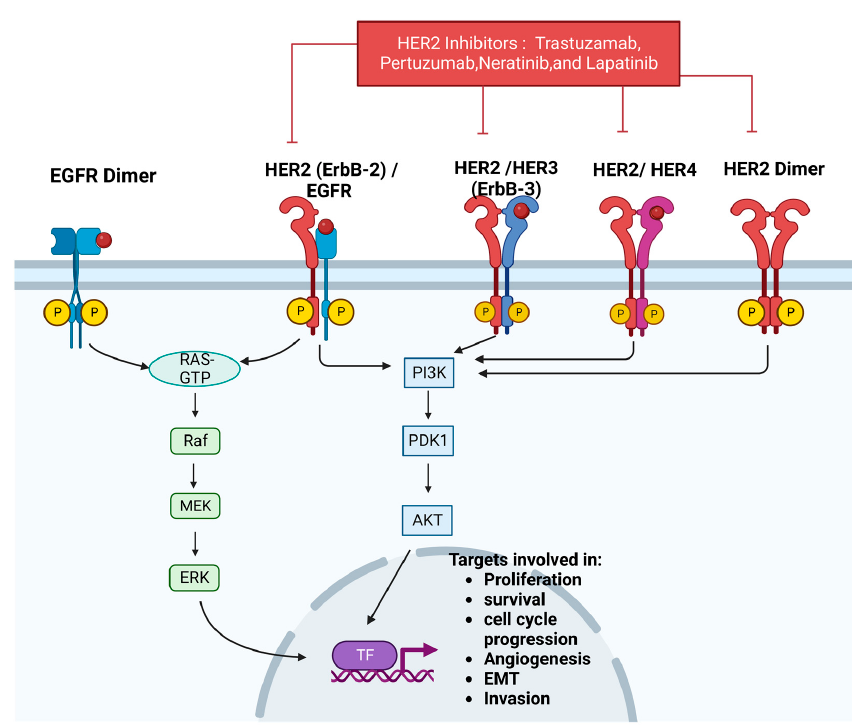
Figure 9. EGFR, HER2, HER3, HER4 signaling pathways. Created with